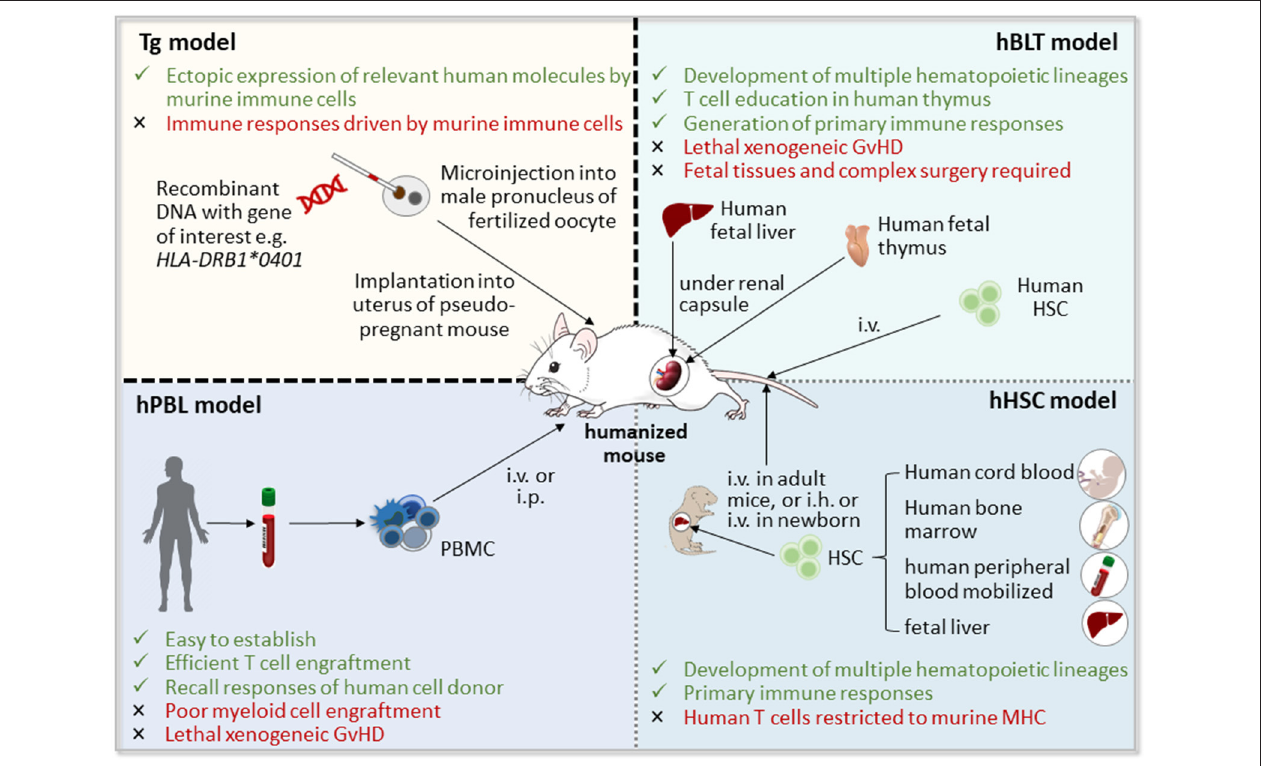
FIGURE 1 | Strategies for the generation of humanized mice [adapted from Shultz (30) and Hahn et al. (31)]. Humanized mice can be obtained by the introduction of human transgenes, such as human leucocyte antigen (HLA) class II molecules, which will then be expressed by mouse immune cells, or by the generation of mouse/human chimera through implantation of human cells, including hematopoietic stem and progenitor cells (HSCs) and peripheral blood mononuclear cells (PBMCs), and/or human tissues, such as fetal liver and thymus, into immunodeficient mice. GvHD, graft vs. host disease; hBLT, human bone marrow-liver-thymus-engrafted; hPBL, human peripheral blood lymphocyte-engrafted; i.h., intrahepatic; i.p., intraperitoneal; i.v., intravenous; Tg, transgenic